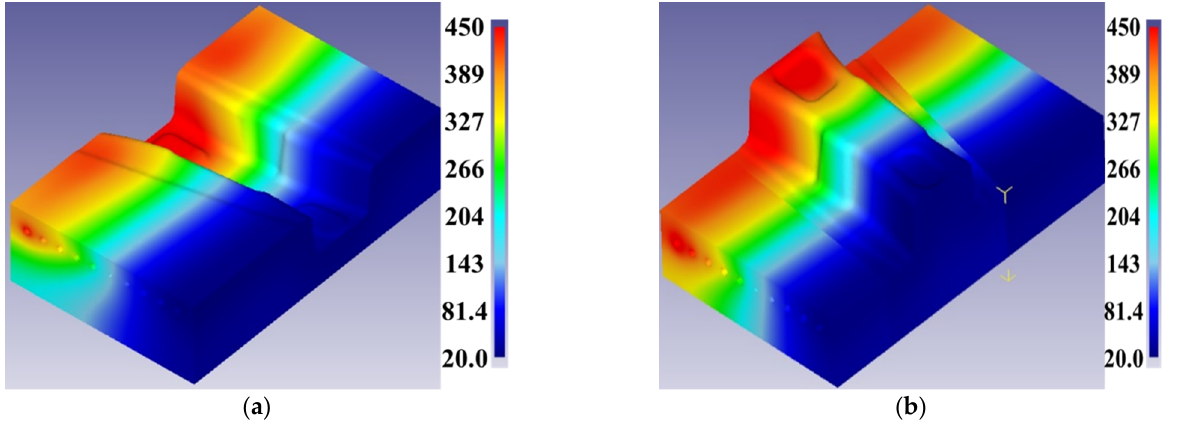
Figure 19. Temperature distribution of ( a ) top die and ( b ) bottom die.